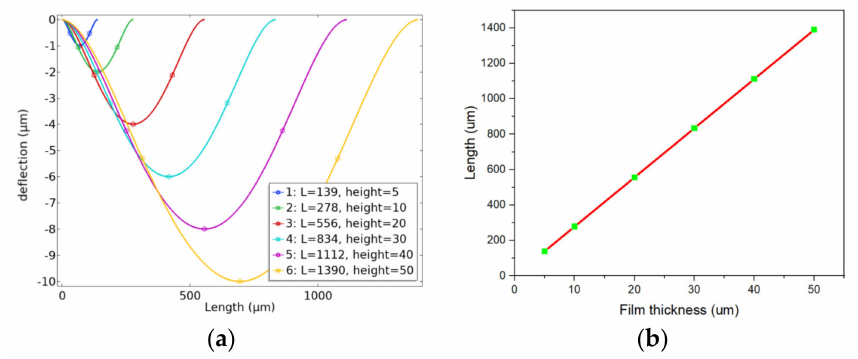
Figure 3. ( a ) Optimum film size for different film thicknesses; ( b ) relationship between film thickness and optimal film length.